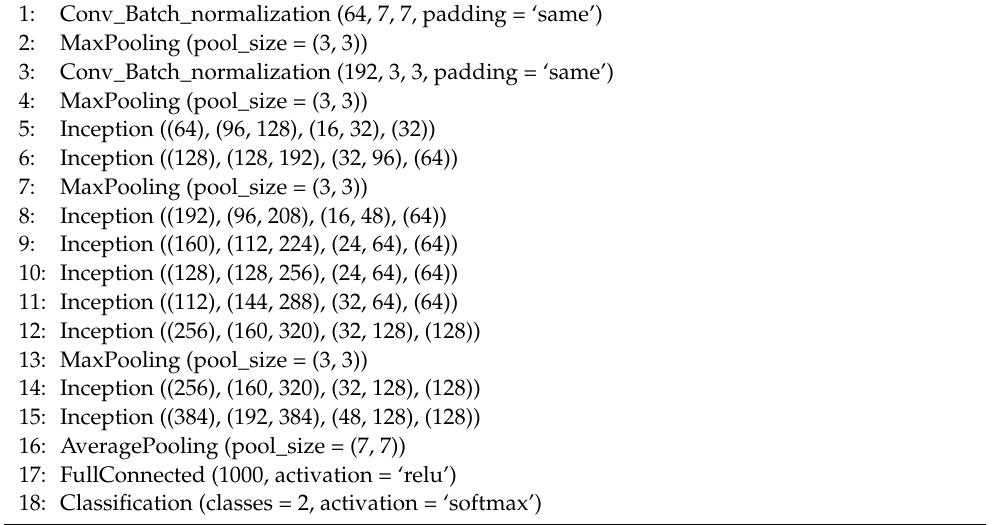
Algorithm 4 CNN architecture of